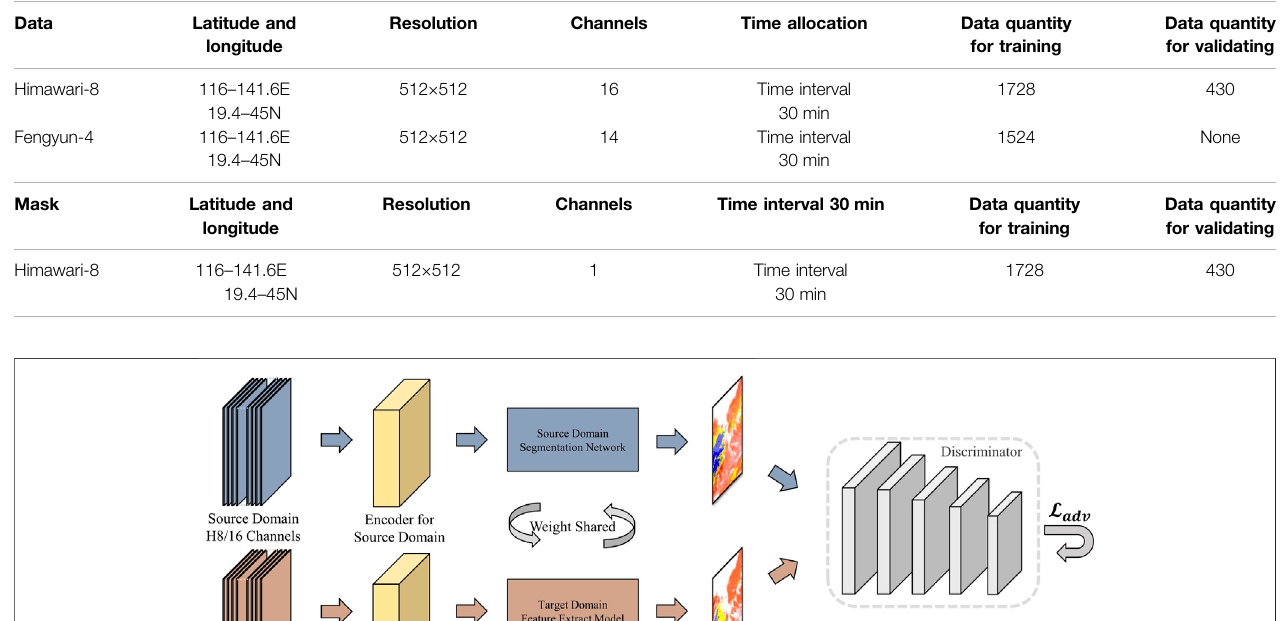
TABLE 2 | Details of experimental data.